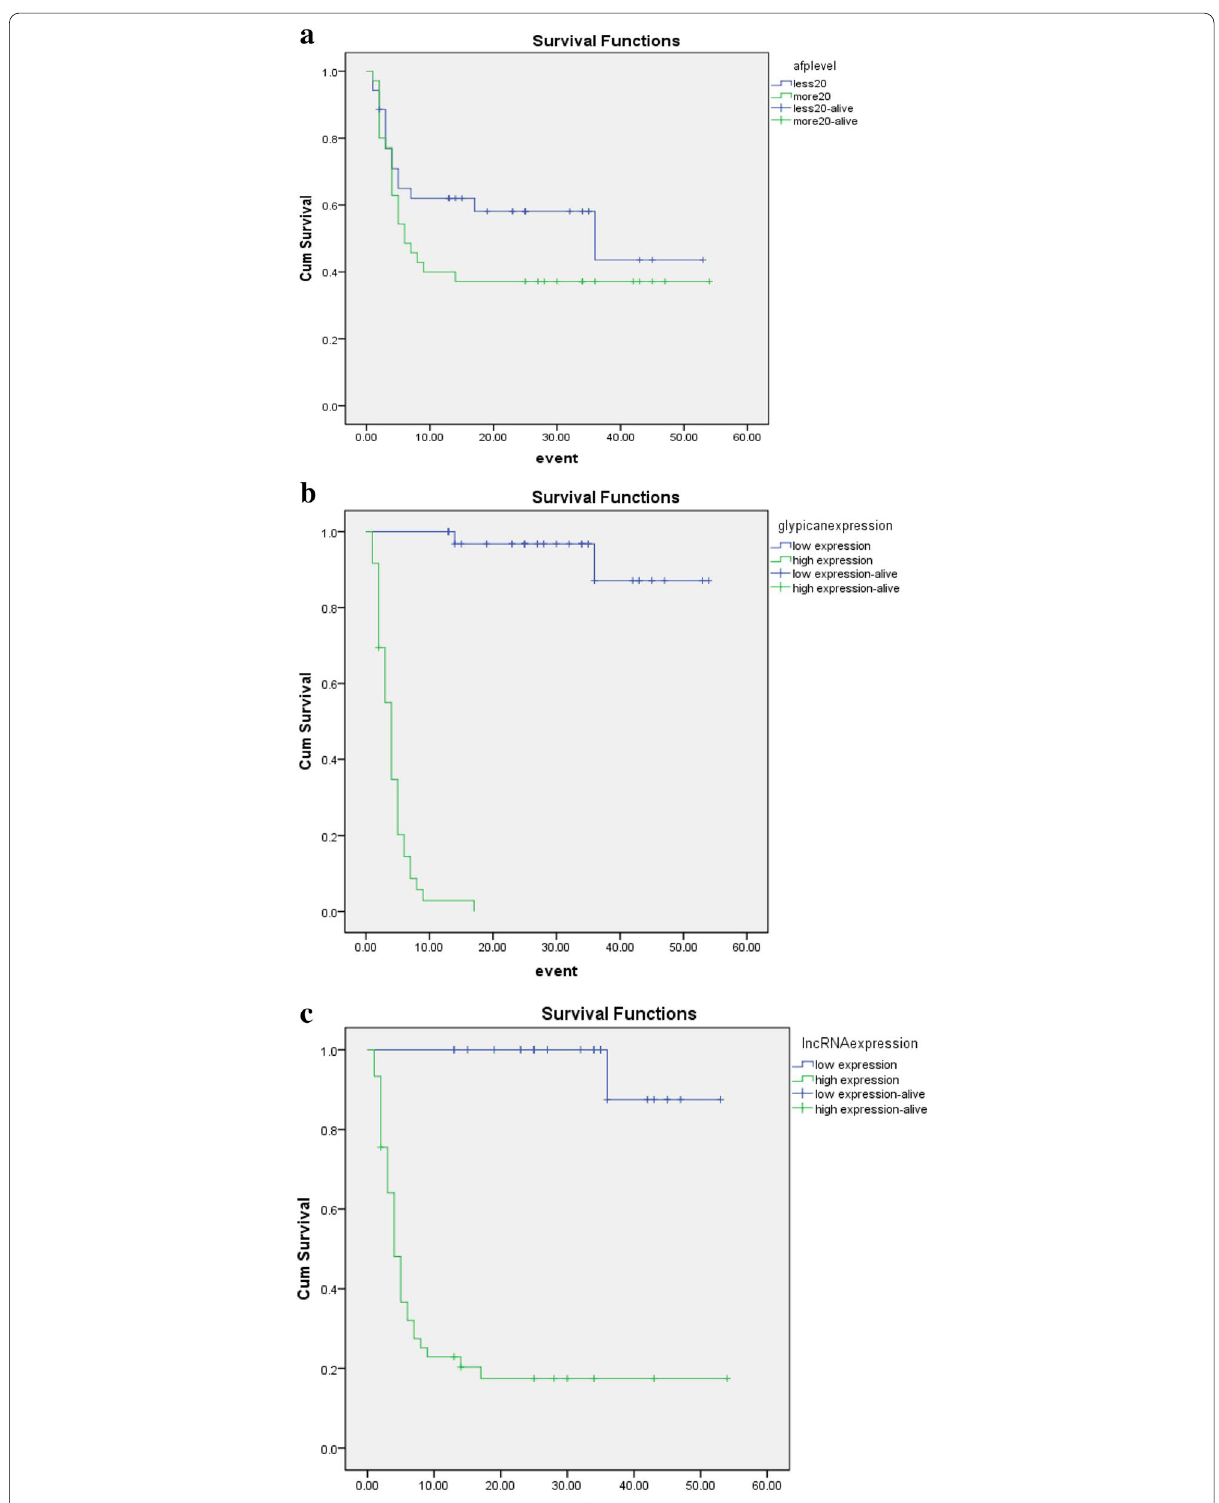
Fig. 2 a The survival curve corresponding to different AFP levels. b The survival curve corresponding to different GPC3 gene expression. c The survival curve corresponding to different lncRNA AF085935